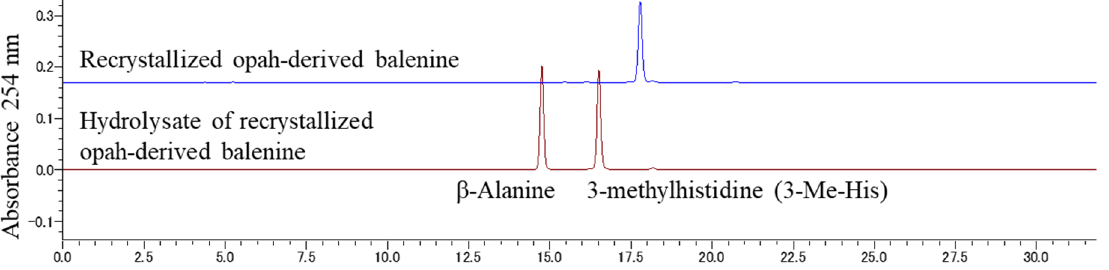
Figure 2. Pre-column derivatization HPLC chromatogram of opah-extracted balenine and hydrolyzed balenine. The chromatograms show balenine and its hydrolysate without impurities.